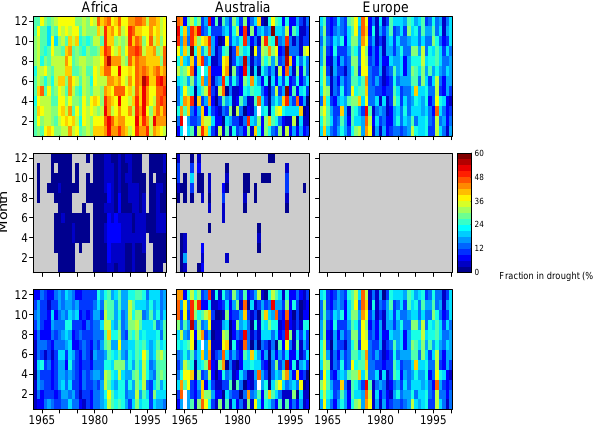
Fig. 11. Location of the grid cells (dark gray colour) in which peri- ods with zero runoff occur according to the ensemble median of five LSMs and where the CDPM can be applied. The black cells indi- cate the area without runoff during the entire time series (hyper-arid cells), which have been excluded from the analysis.